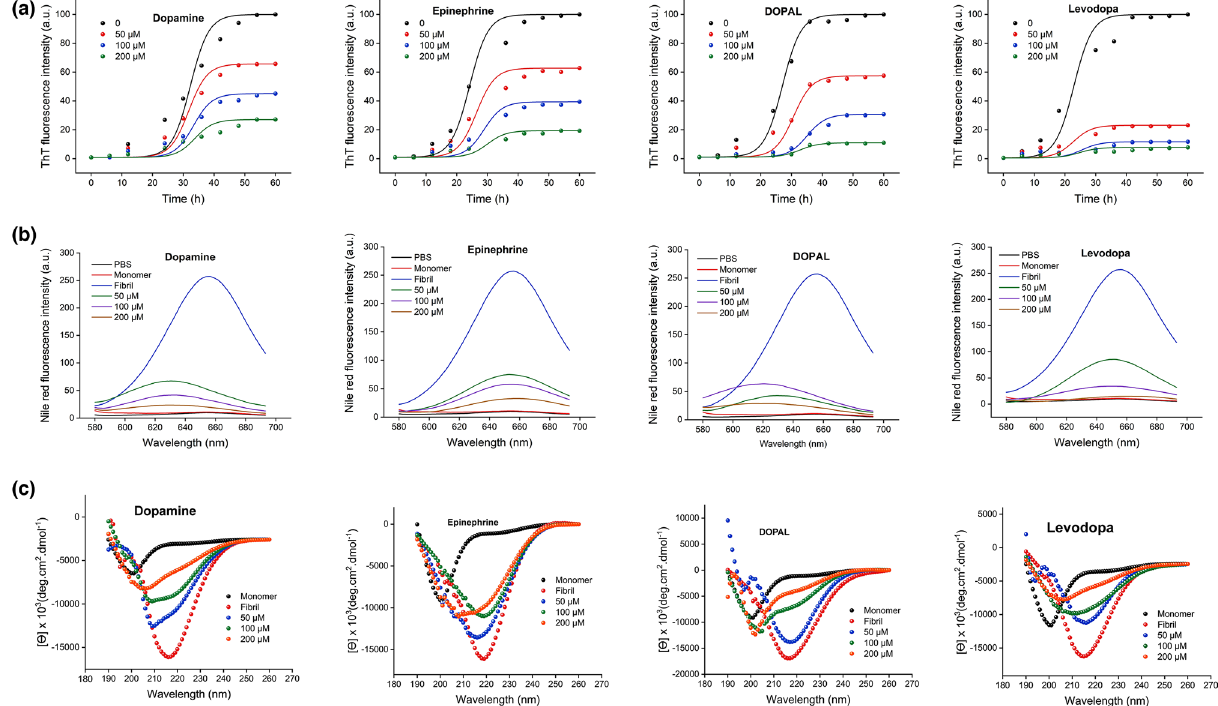
Figure 2. The effect of catechols on the α-syn amyloid fibril formation. Protein samples (200 µM) were incubated at 37 °C either alone or with increasing concentrations of catechols for 60 h. ( A ) The kinetics of α-syn amyloid fibrillation indicated by increasing fluorescence intensity of ThT at 485 nm. ( B ) Changes in the surface hydrophobicity of α-syn as monitored by NR fluorescence assay. ( C ) Far-UV CD spectra of α-syn incubated alone or in the presence of increasing concentrations of catechols. Data are expressed as mean ± SD with n =